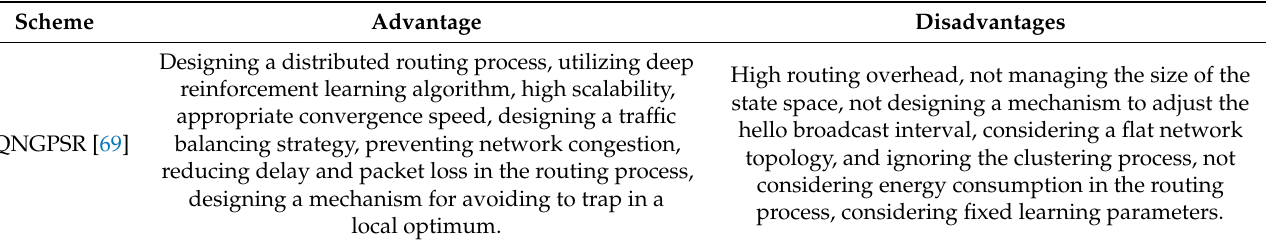
Figure 28. Learning process in TQNGPSR. Table 10. The most important advantages and disadvantages of